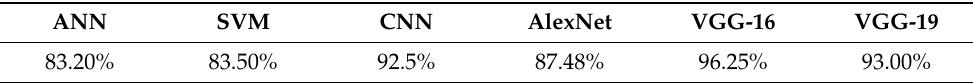
Table 7. A summary of best results given by the 6 used tools for Nosema